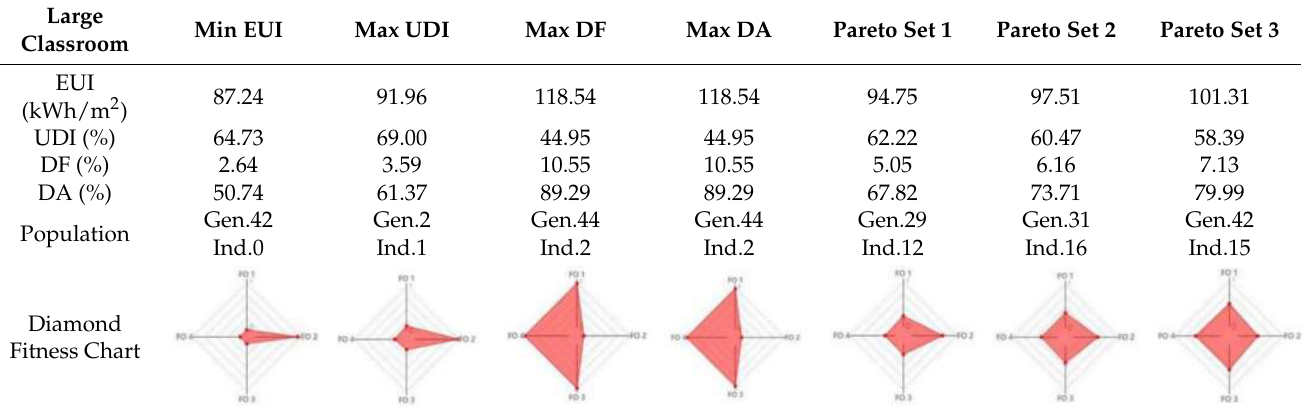
Table 15. The case of large-sized classrooms with window openings on the west and south